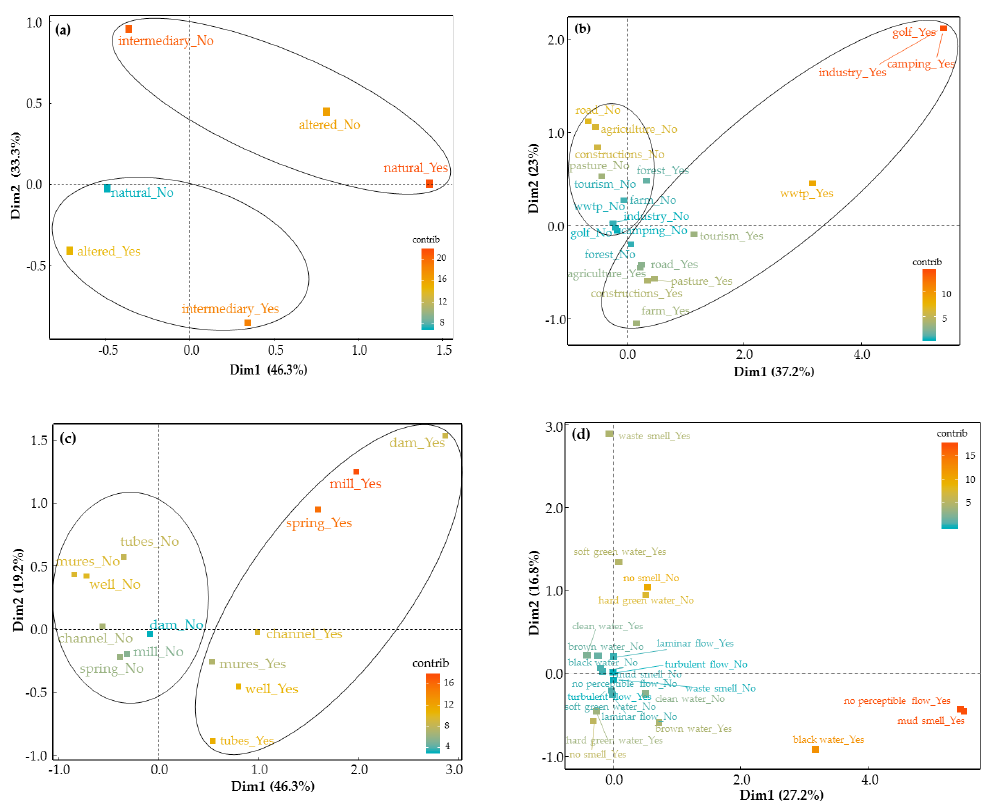
Figure 4. Multiple Correspondence Analysis (MCA) showing the first two dimensions (Dim1 and Dim2) with samples arranged according to data in field forms. Four groups of descriptors are represented separately to avoid overlap of the vectors—( a ) stream characteristics, ( b ) land use, ( c ) settlements on the stream, and ( d ) state of the water. The importance of contributing variable categories is shown by the color scale (from blue to red). Yes = Presence, No = Absence, wwtp = wastewater treatment plant.